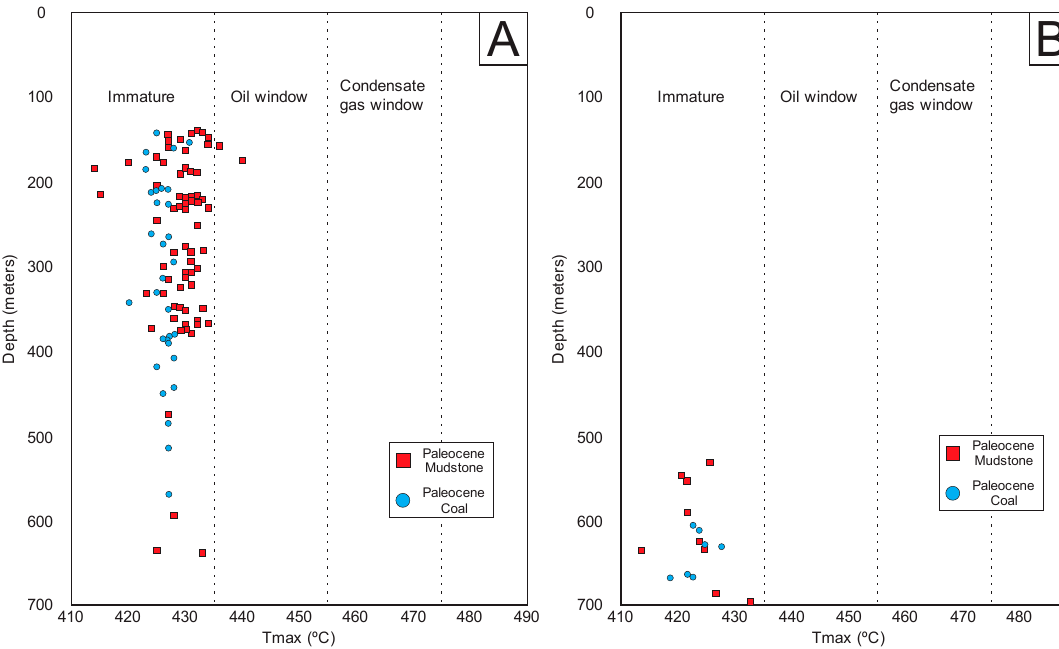
Figure 13. Cross plot of production index (PI) versus Tmax ( ℃ ) to identify source rock maturity in the Cerrejón Formation of the ( A ) ANH-CARRETALITO-1 and ( B ) ANH-CAÑABOBA-1 wells.